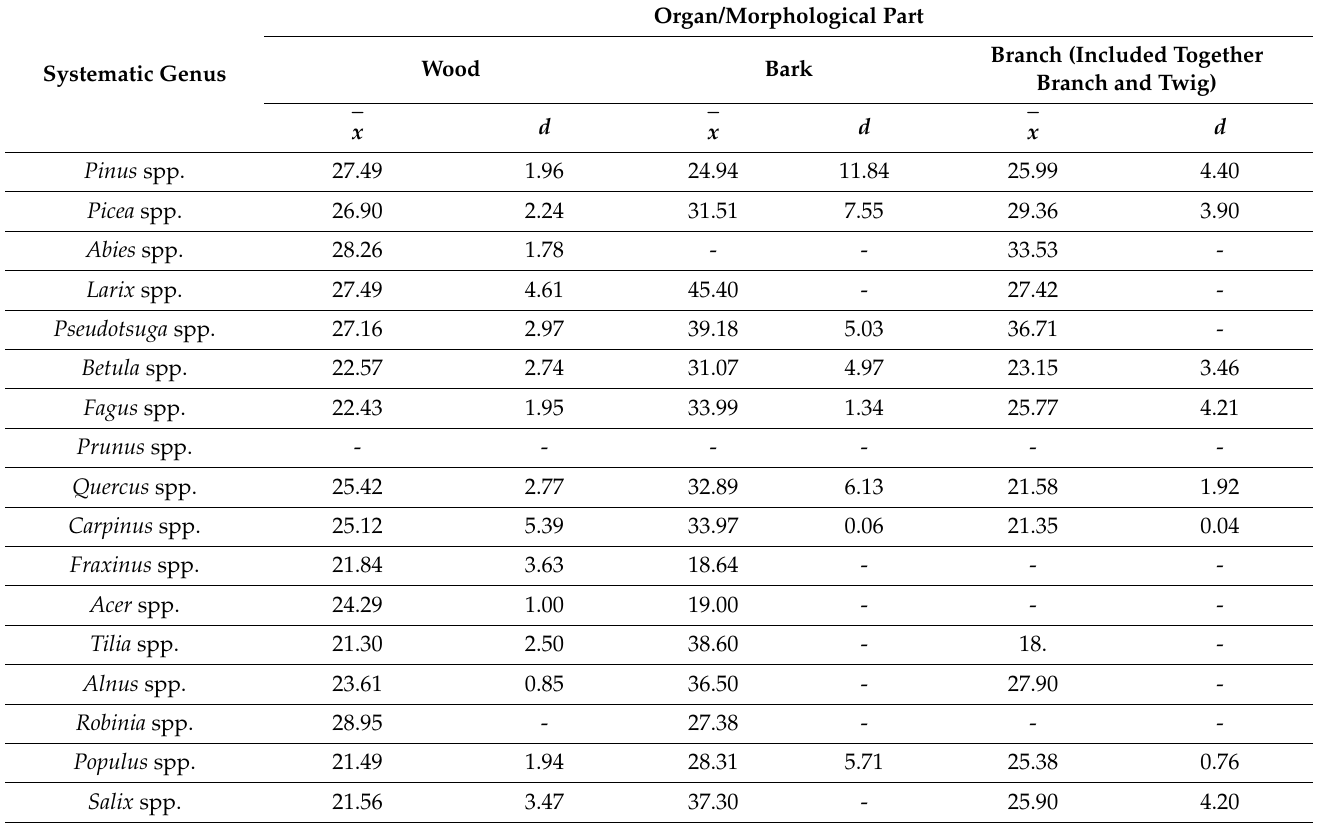
Table A23. Average value and average deviation of the lignin content (% d.m.) in various organs of particular systematic genera trees.